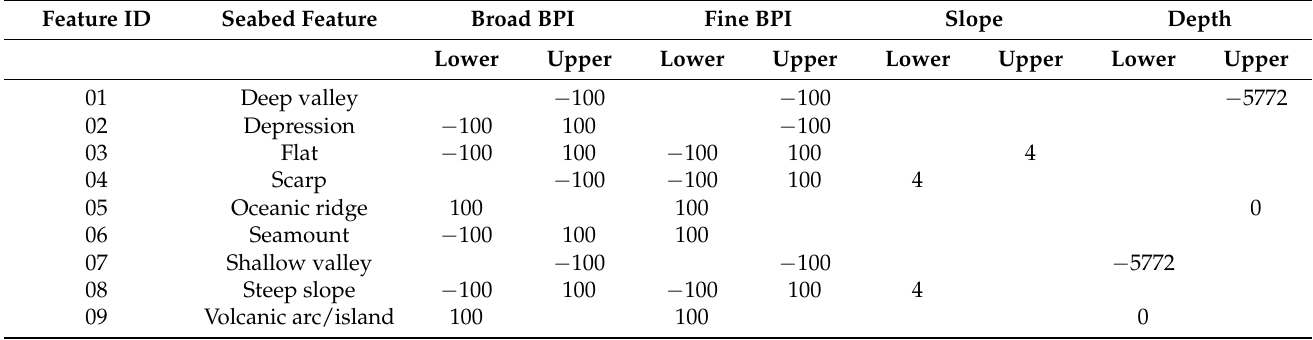
Table 2. The customized classification dictionary. The upper and lower limits of the broad and fine BPIs range between positive and negative (100). The negative denotes values below the default curve, while the positive denotes the value above the default curve [49]. The slope threshold of 4 degrees was used to distinguish between flats, steep slopes, and scarps. The threshold of 5772 m water depth was used to distinguish between deep valleys (trenches) and shallow valleys (mainly